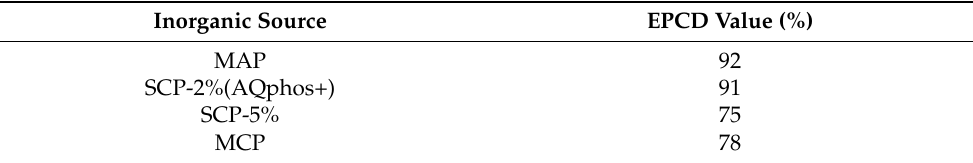
Table 2. Predictive values of P digestibility (%) obtained by Predictive Equations for Digestibility Comparison (EPCD) of inorganic phosphates adapted for fish.